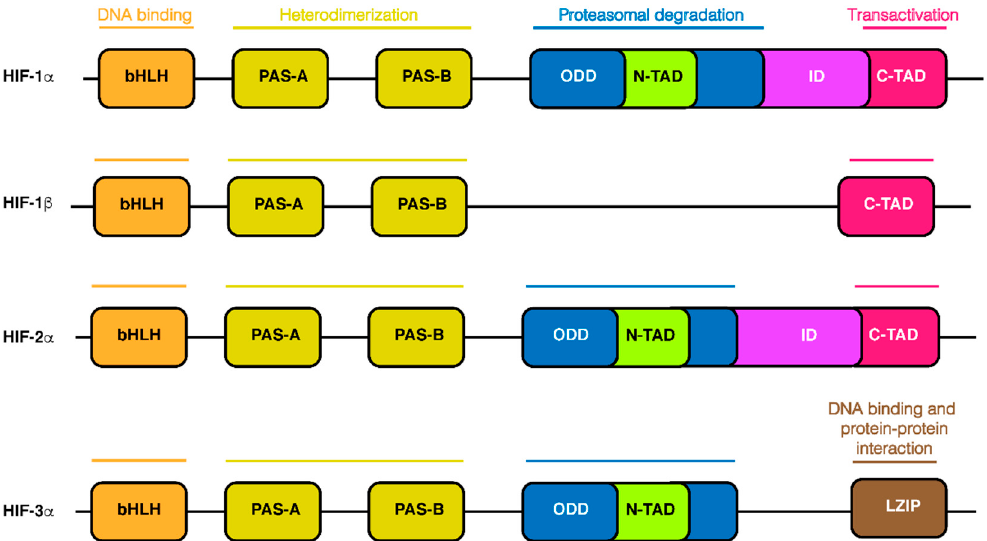
Figure 1. Domain structures of HIF-1 α in comparison with other HIF proteins and their potential function. Different functions of various domains are represented at the top. All HIF isoforms have a bHLH motif and two PAS domains (PAS-A and PAS-B) for the heterodimerization. HIF-1 β does not contain the oxygen-dependent degradation (ODD) domain, that mediates proteasomal degradation, N-TAD, and the inhibitory domain (ID). Isoform HIF-3 α , without the C-TAD which mediates transcriptional activation and ID, shows a LZIP involved in DNA binding and protein–protein interaction.